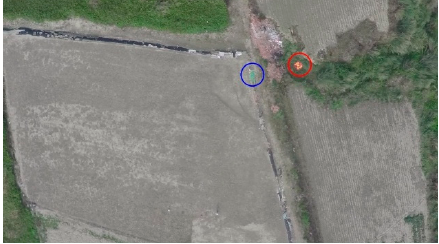
Figure 11. A red target board and a green agricultural net reported by the post-identification program, with both the red and blue targets marked with circles in corresponding colors.